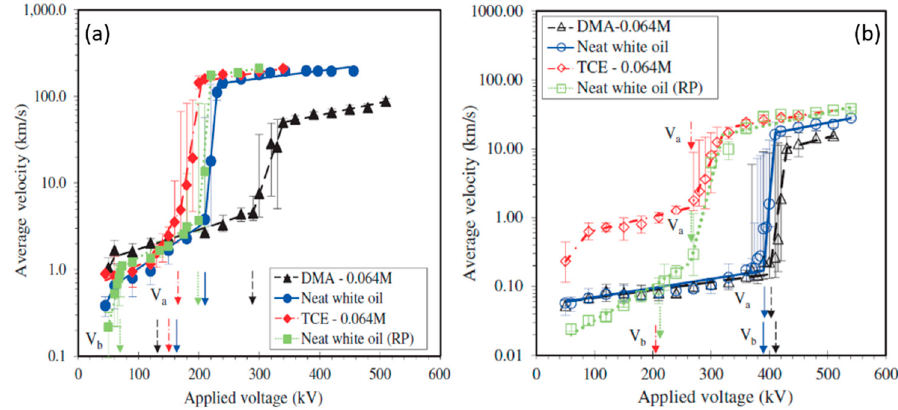
Figure 19. Average velocity of ( a ) positive and ( b ) negative streamers versus applied voltage [RP: reduced pressure]. Reprinted with permission from [334].